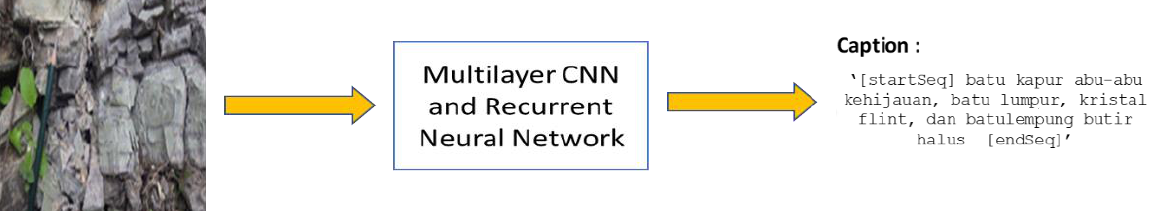
Figure 1. Research Problem on captioning geological terms. The translation of the caption is greenish-gray limestone, mudstone, flint crystal, and fine-grain claystone (CNN: convolutional neural network).